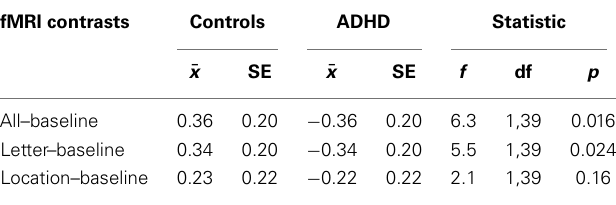
Table 5 | Group differences inAI-curves .